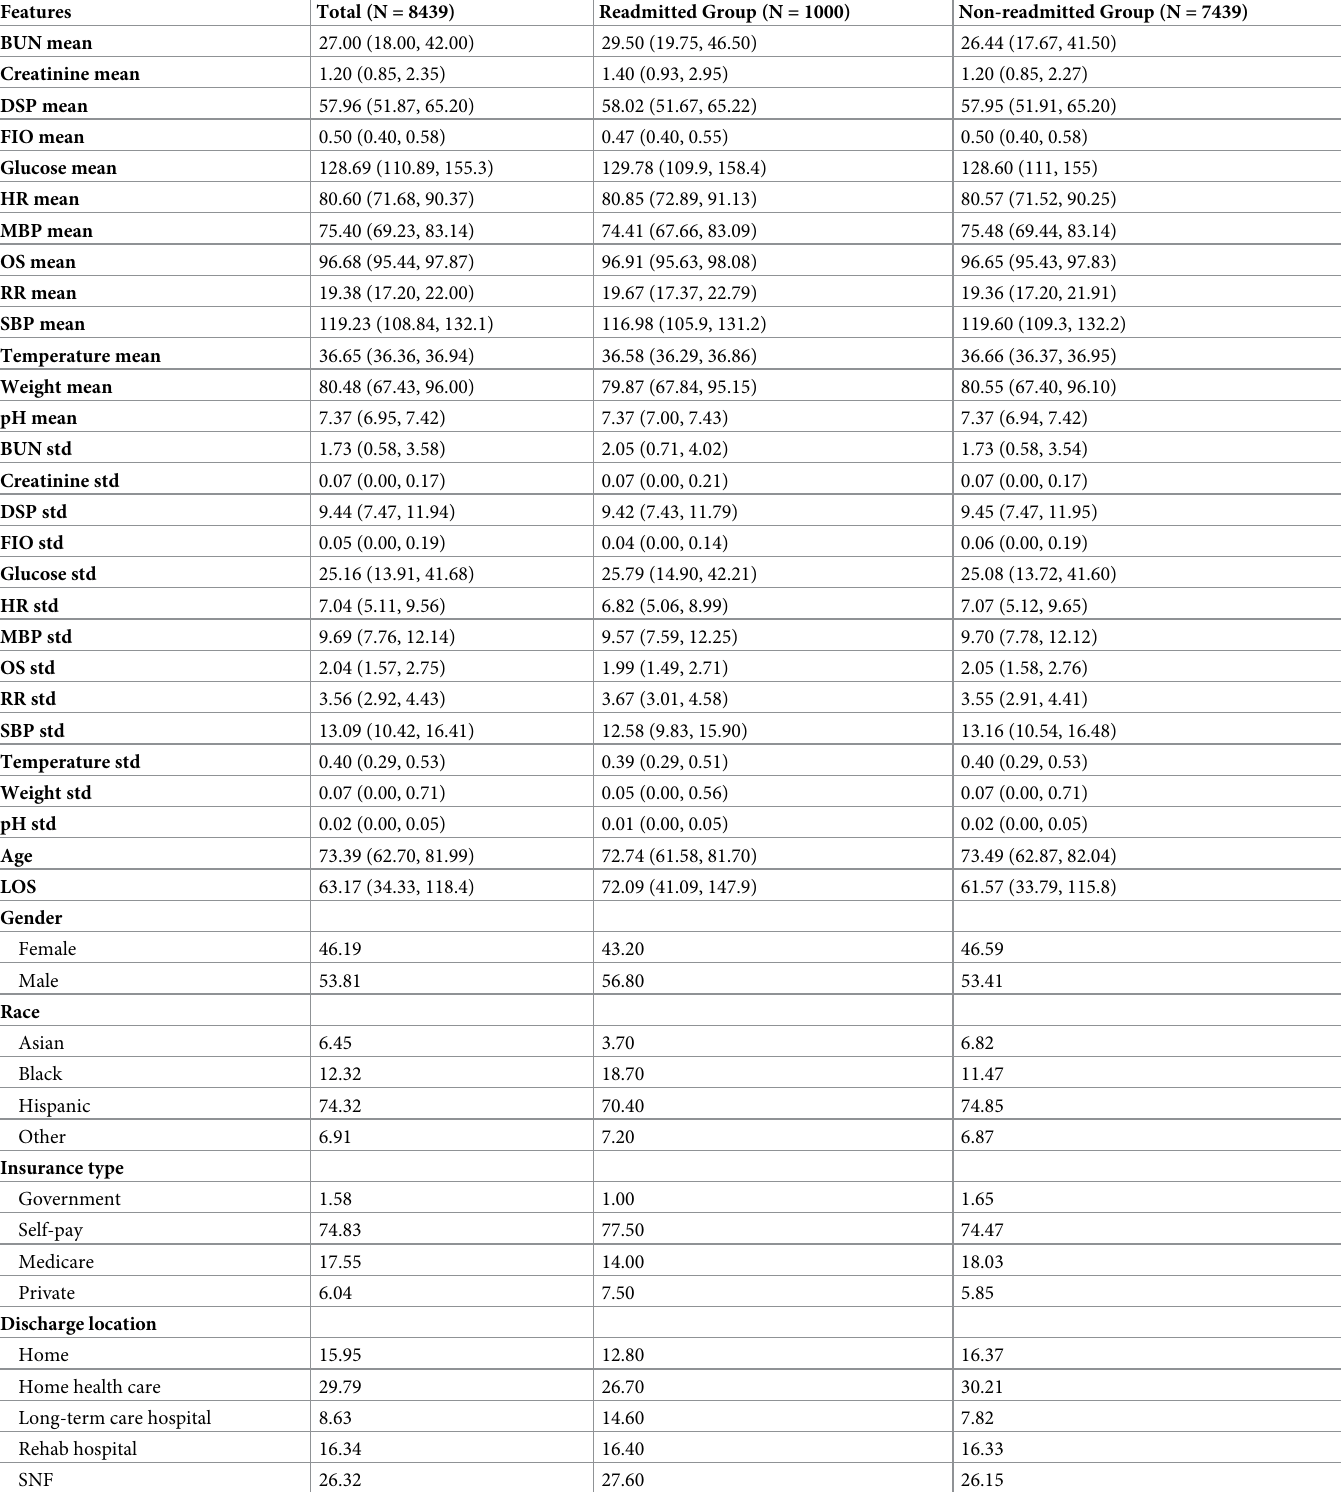
Table 1. Summary of